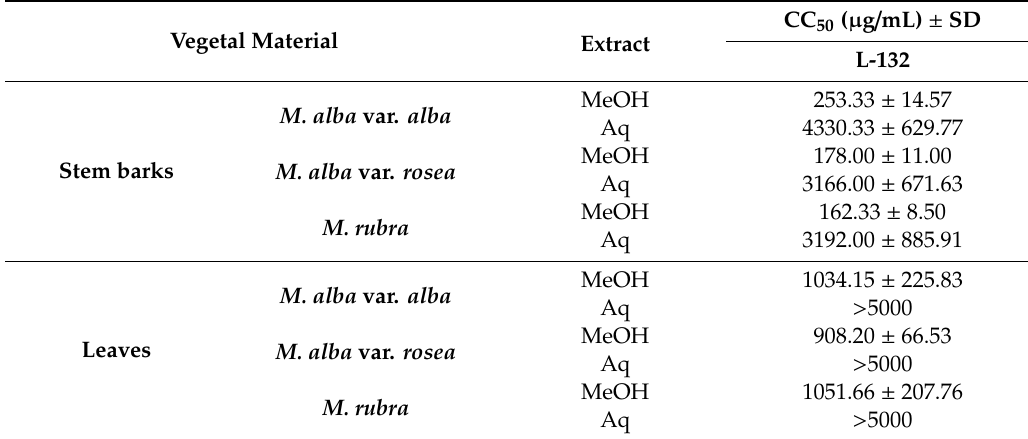
Table 1. In vitro cytotoxic activity of stem barks and leaves’ aqueous and hydromethanolic extracts on L-132 cells. Experiments were performed in triplicate, and the results are representative of three independent experiments.